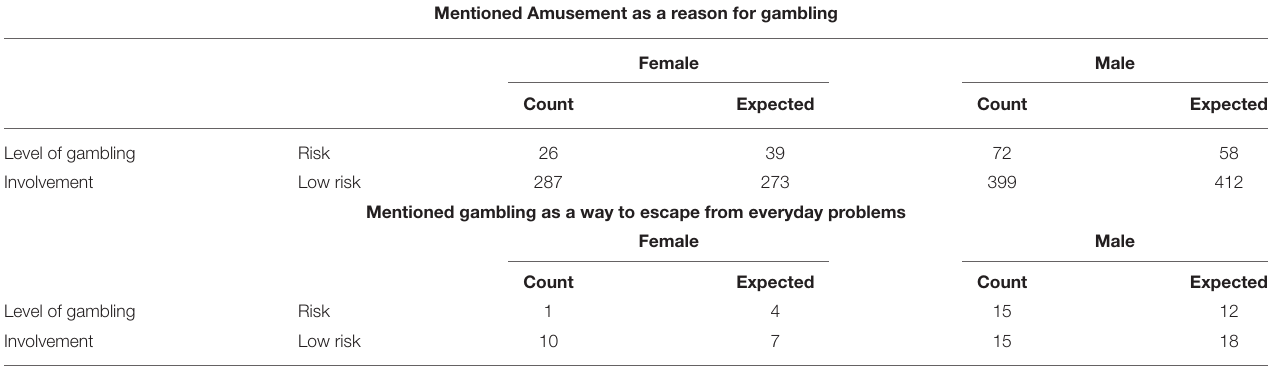
TABLE 4 | Level of gambling involvement based on the combination of gender and gambling